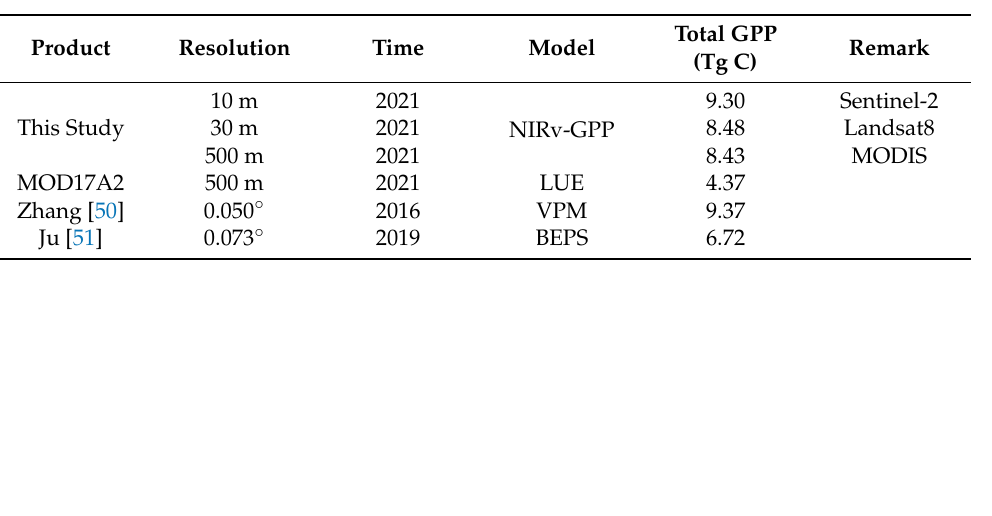
Table 2. Comparison of urban contribution to GPP in different GPP